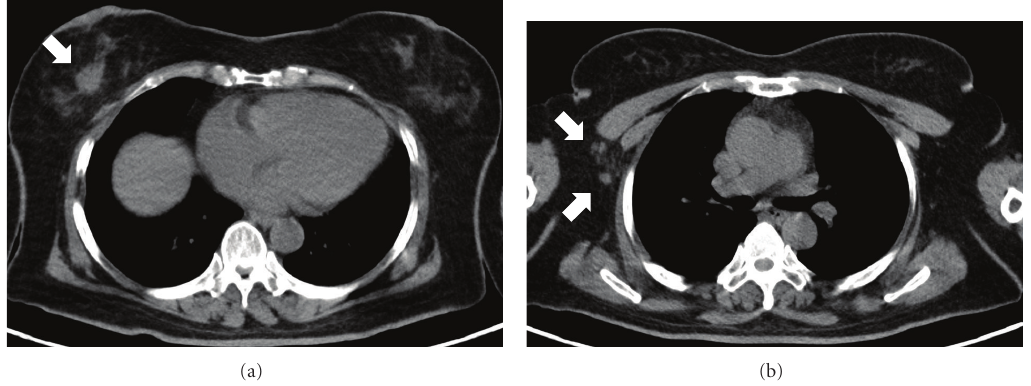
Figure 3: Incidental right breast mass (a) arrow, 2 . 7 × 1 . 7 cm in size) and several right axillary lymph nodes (b) arrows, the largest one is 1 . 0 × 0 . 8cm in size) in a 59-year-old female with history of endometrial cancer were found by followup unenhanced CT of 18 F-fluoride PET/CT. The biopsy for the right breast tumor confirmed the presence of invasive ductal